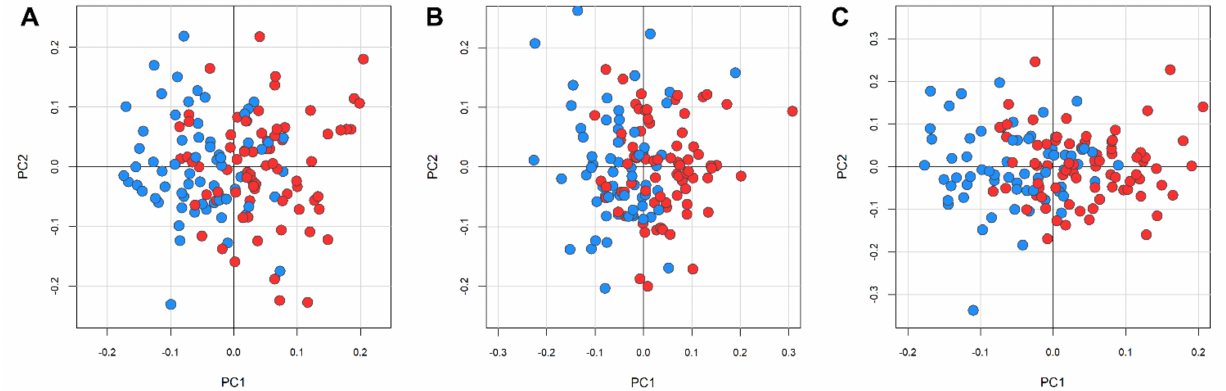
Figure 2. Clusterization of serum metabolomic fingerprints. Discrimination between patients free from eCRC disease relapse (light blue, dots, n = 65) and patients with mCRC (red dots, n = 75) using the PCA-CA-kNN analysis. Score plot of the first two principal components ( A ) NOESY1D; ( B ) CPMG; ( C ) Diffusion.